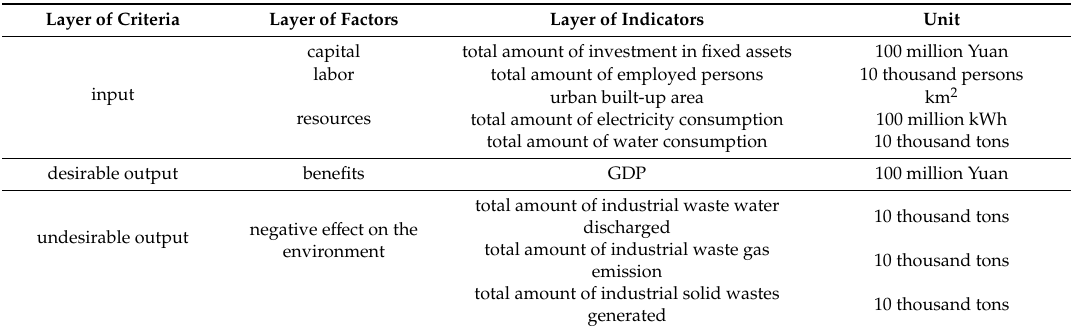
Table 1. Evaluation index system of eco-e ffi